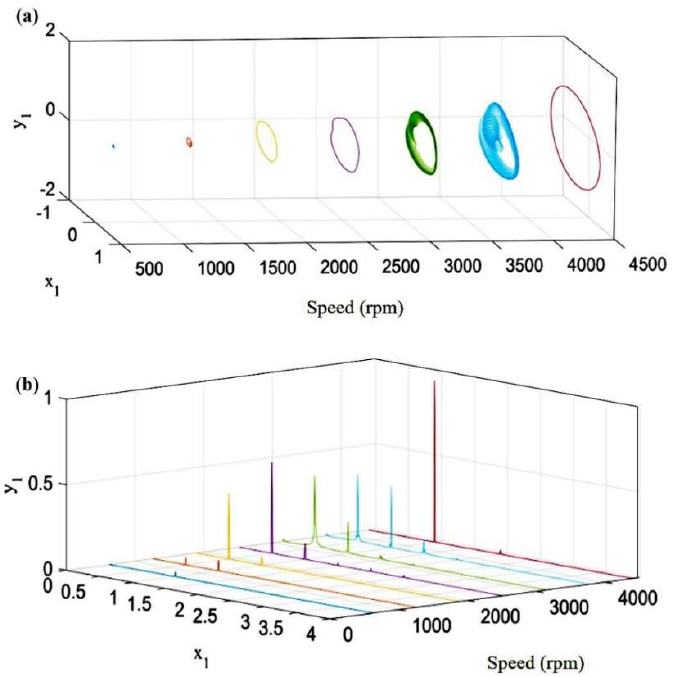
Figure 9. ( a ) Rotor axis trajectory at different speeds. ( b ) Rotor spectrum at different